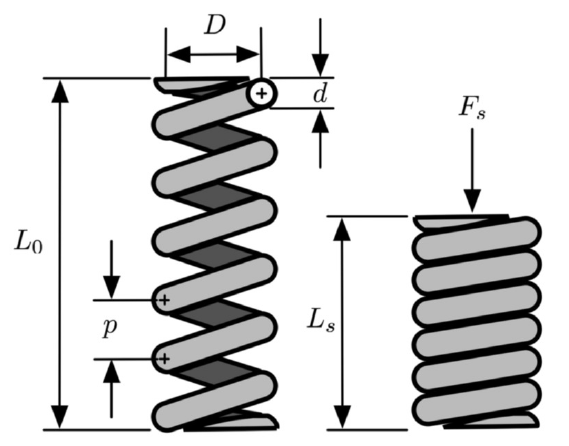
Figure 8. Extension/compression spring structure.